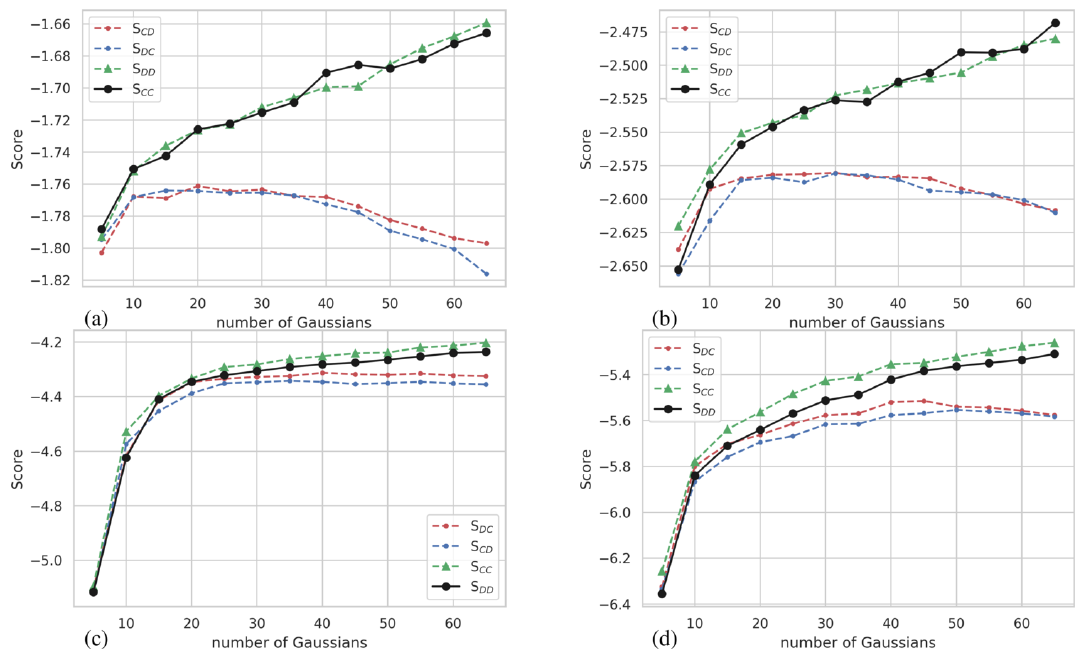
Figure A2. Score, S ij as a function of number of Gaussians used in the GMM fit. Black and green lines indicate score for i = j and red and blue lines indicate scores for i (cid:54) = j . ( a ) RunC and RunD for CAPTEX1 at 09/20/1983 0 UTC. ( b ) RunC and RunD for CAPTEX1 at 09/20/1983 03 UTC. ( c ) RunKC and runKD at 08/09/2008 at 04 UTC. ( d ) RunKC and RunKD at 08/10/2008 12